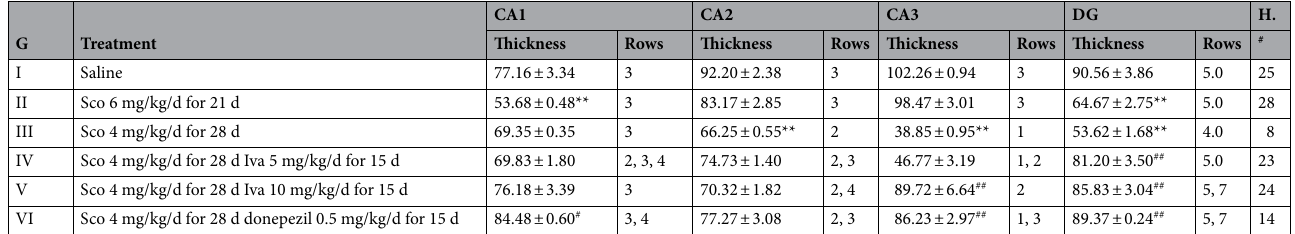
Table 3. Indicating the SP-thickness, number of rows of the pyramidal layer of various HC subfields (CA1, CA2 and CA3), SG-thickness of the granular layer of DG, number of rows and number of cells in the hilum in different groups. Sco scopolamine, Iva ivabradine, HC hippocampus, CA cornu ammonis, DG dentate gyrus, H hilum, SG stratum granule. Values are expressed as mean ± SEM of (8–10) rats. Analyzed using by one way ANOVA P < 0.01. **Highly significant (P > 0.01) difference from control group. # Significant (P > 0.01) and ## highly significant (P > 0.01) difference from dementia control